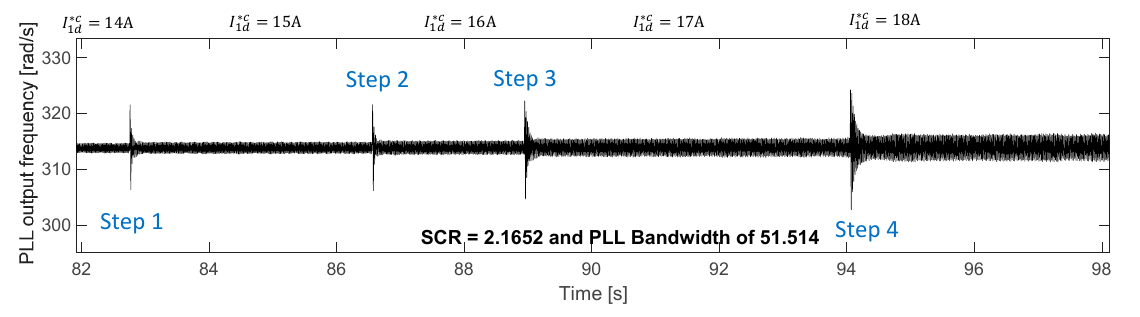
Figure 18. Transient response of frequency at the PLL output for a SCR of 2.1652 and for a PLL BW of 51.514 Hz, in the 4 steps considered in for the validation—Matlab data logging of the experimental waveforms. Table 7. Comparison between the damping of modes 7 and 8 given by the proposed model and the those found in the experimental system, for a SCR = 1.4463 and PLL bandwidth equal to 20.344 Hz. Reference Value in the Converter